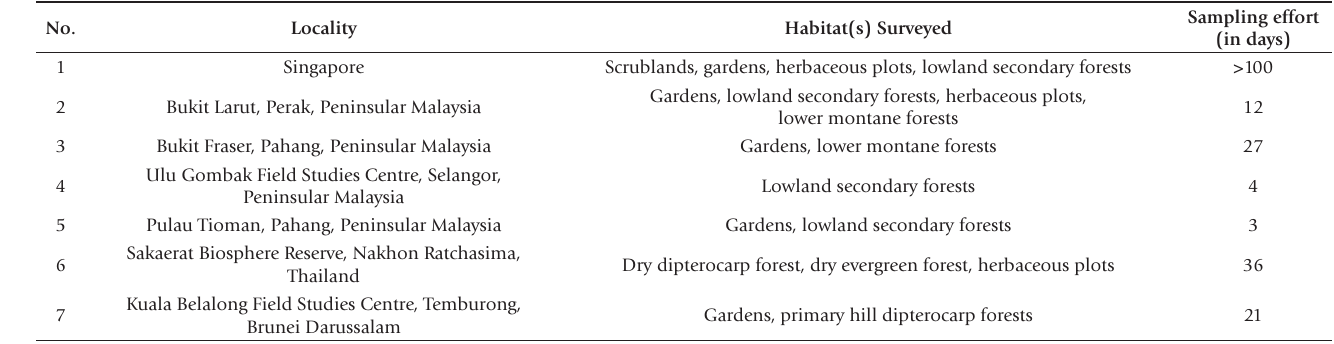
Table 1. A list of localities and habitats surveyed between 2015–2017.